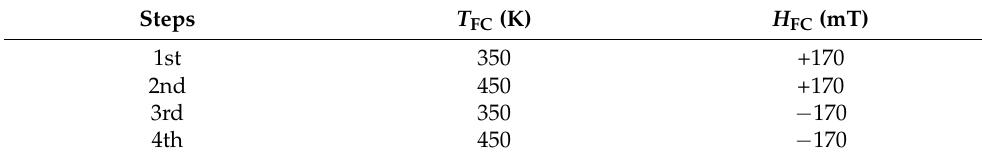
Table 1. Combinations of heating temperatures and signs of H FC for each field cooling (FC)